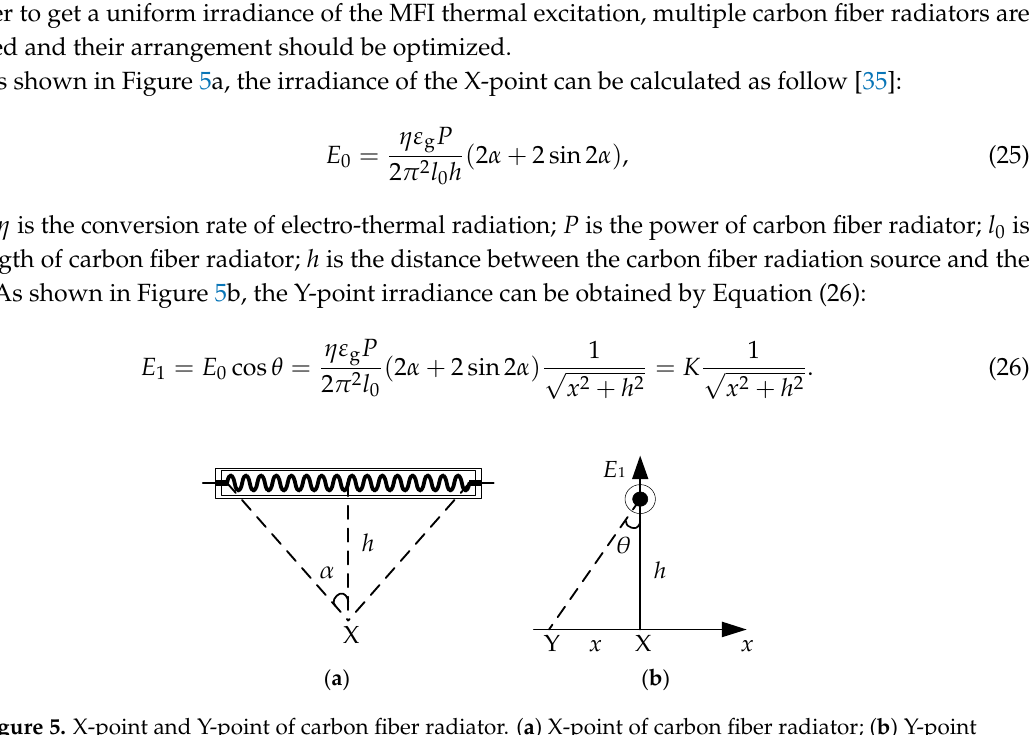
Figure 5. X-point and Y-point of carbon fiber radiator. ( a ) X-point of carbon fiber radiator; ( b ) Y-point of carbon fiber radiator.